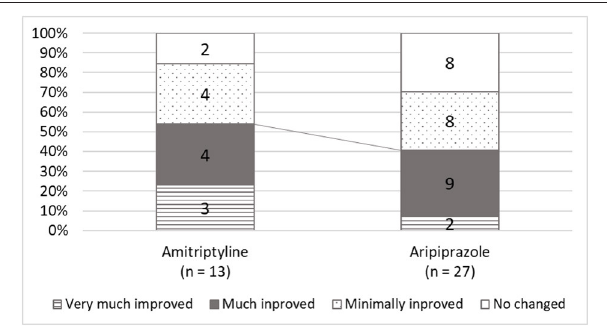
FIGURE 3 | The scores of global improvements in clinical global improvement (CGI). While amitriptyline was responded to in 84.6% of patients and clinically